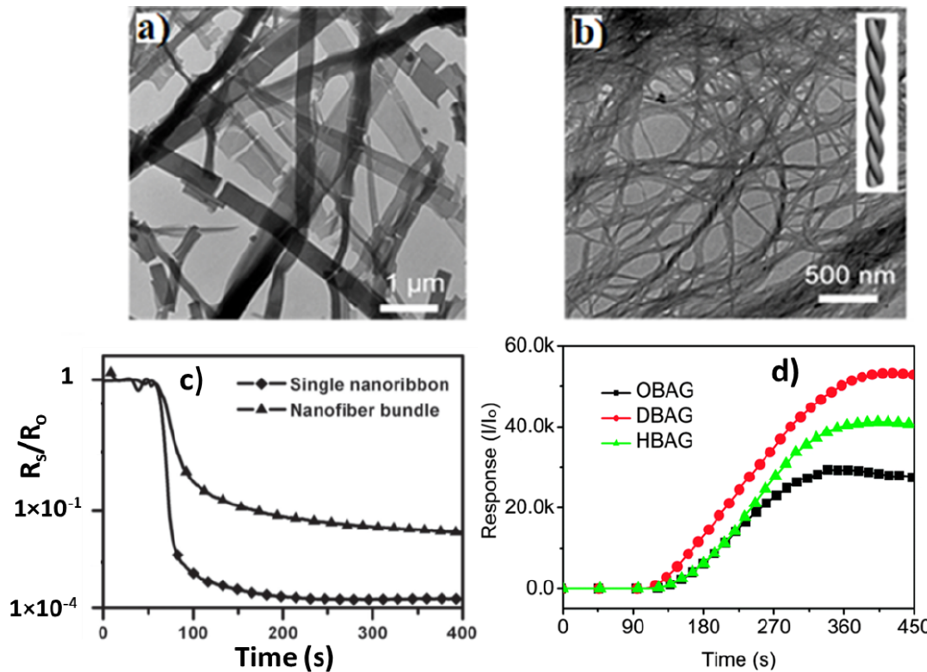
Figure 4. TEM images of PDI-BAG ( a ) nanoribbons and ( b ) nanofiber obtained from H 2 O/DMF ( N , N - dimethylformamide) mixed solvents with different volume ratios of 20/80 and 60/40, respectively. ( c ) Sensing responses of single nanoribbon and nanofiber bundles after the injection of hydrazine vapor. ( d ) Sensing responses of OBAG, DBAG, and HBAG devices obtained from THF/H 2 O (20/80 v/v ) in hydrazine vapor. Adapted with permission